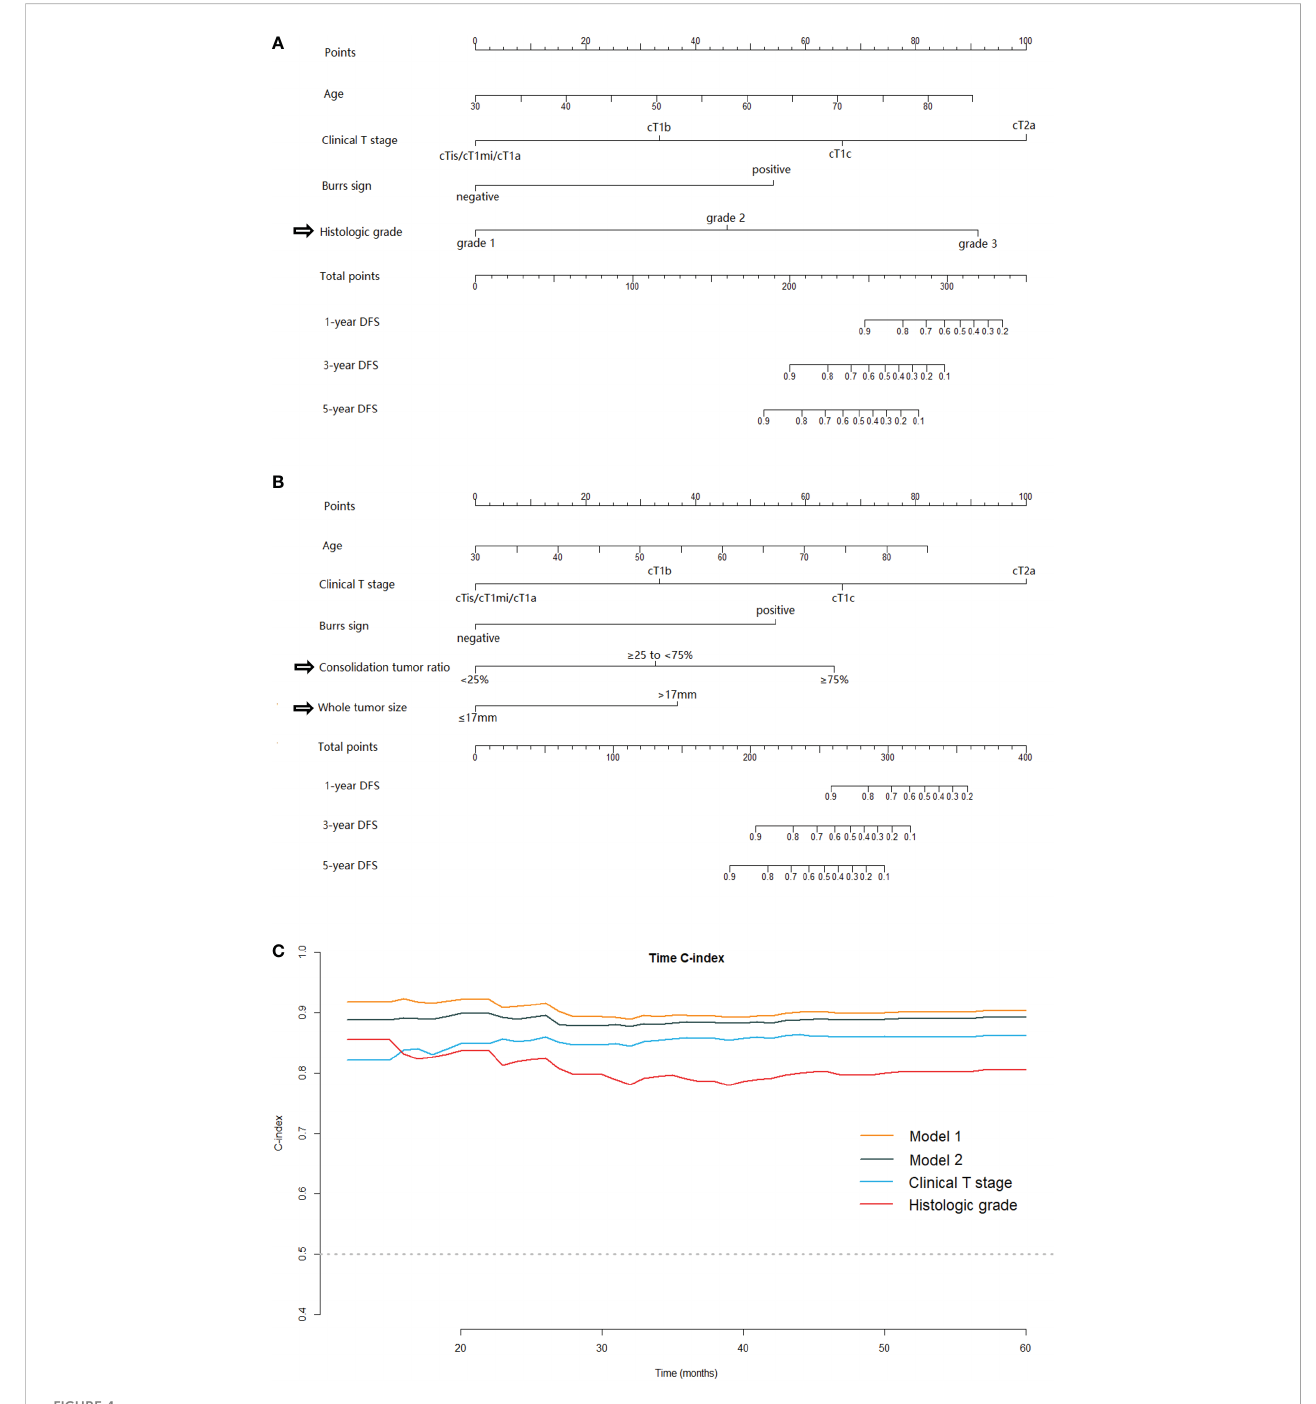
FIGURE 4 The nomogram models for predicting DFS for patients with pathological stage I LUAD and the C-index estimates over time. Model-1 (A) and Model-2 (B) for predicting the 1-, 3 ‐ and 5 ‐ year DFS rates. (C) The time ‐ dependent C ‐ index of model 1, model 2, clinical T stage and histologic grade. DFS, disease-free survival; LUAD, lung